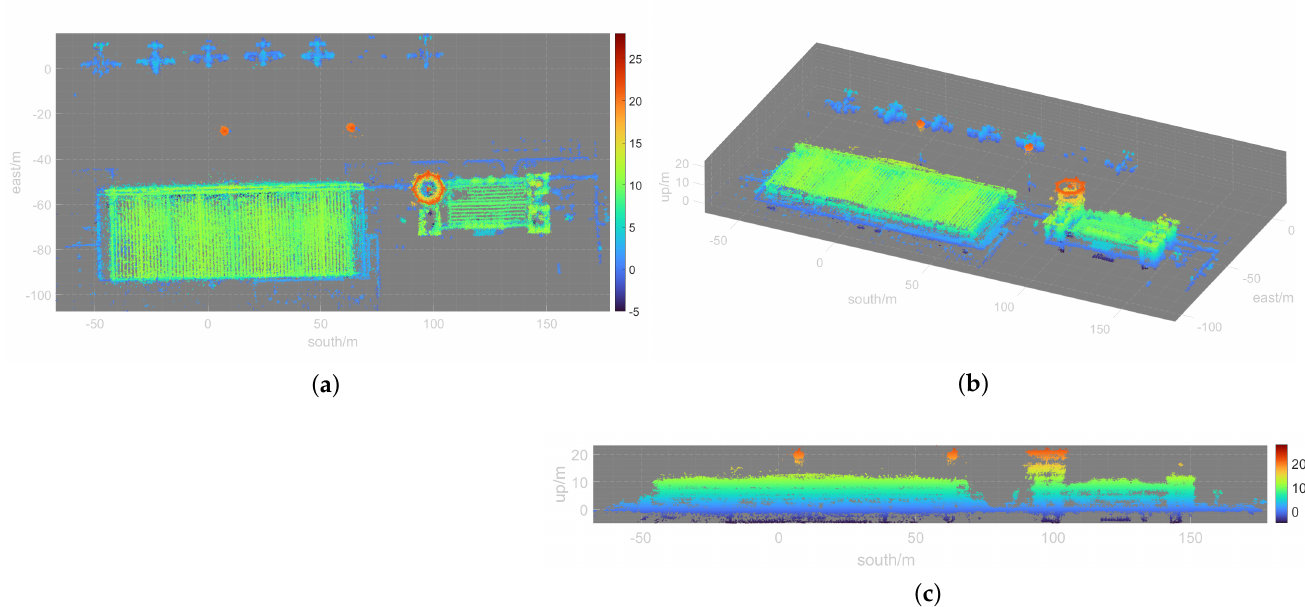
Figure 8. Airport 3D reconstruction. This figure contains 1.6 million points. The result is displayed in a Cartesian coordinate system. ( a ) Top view. ( b ) Perspective view. ( c ) Side